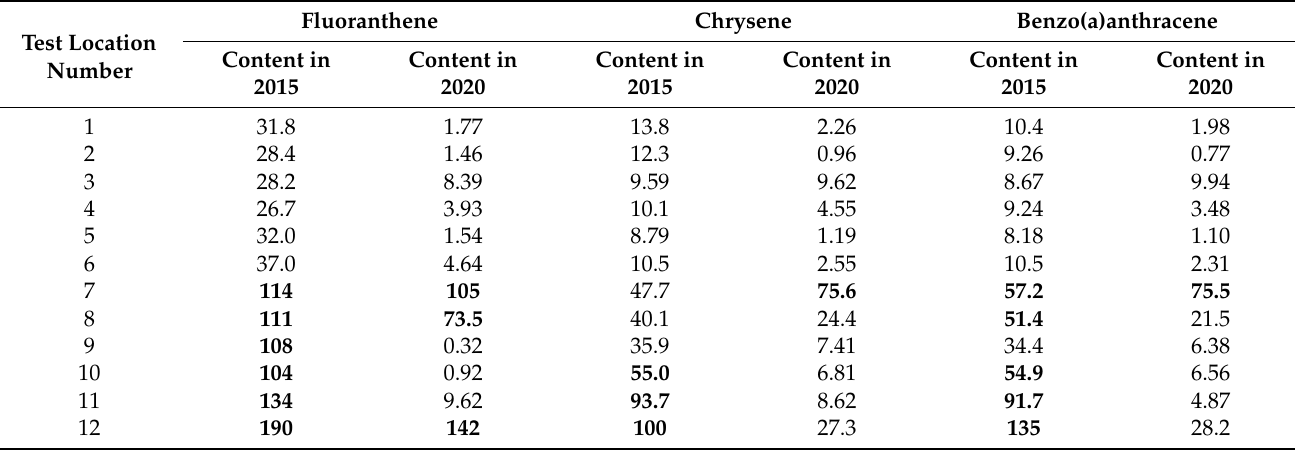
Table 5. Changes in the content of fluoranthene, chrysene, and benzo(a)anthracene (mg kg − 1 DM) in the soil before (2015) and after enhanced natural attenuation